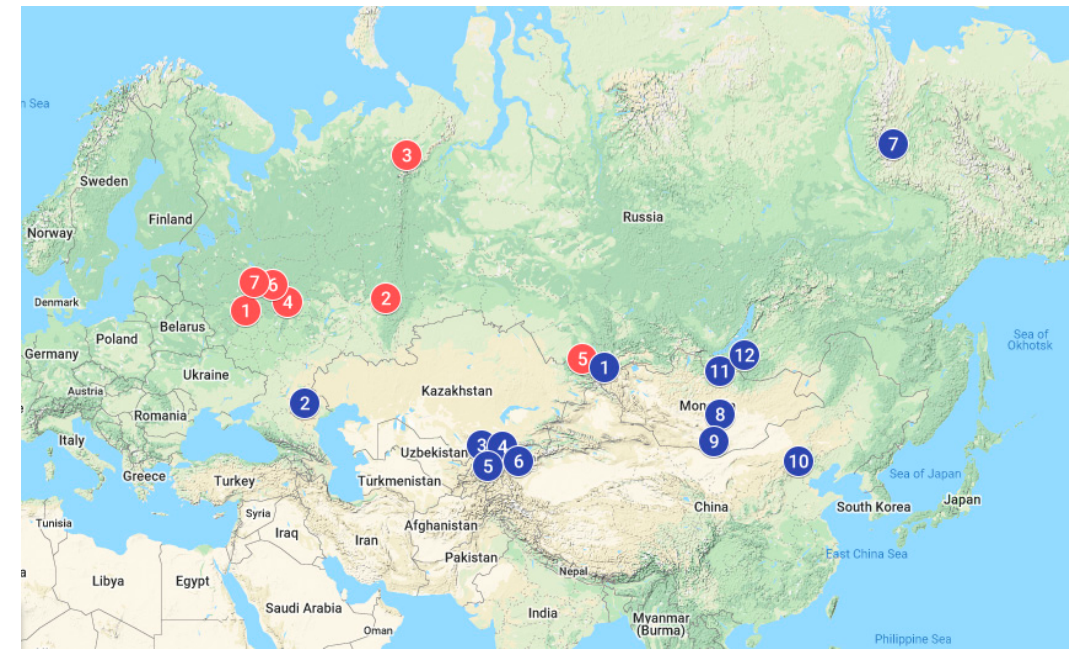
Figure 1. Geographic locations of cattle breeds. A total of 18 cattle breeds were sampled in this study, including eight European breeds indicated by red dots ((1). Holstein, (2). Tagil, (3). Kholmogory, (4). Red Gorbatov, (5). Ukrainian Grey, (6). Yaroslavl, (7). Brown Swiss and Kostroma) and ten Asian breeds indicated by blue dots ((1). Altai, (2). Kalmyk, (3). Aulie-Ata, (4). Kyrgyz Beef-type, (5). Alatau, (6). Kyrgyz native, (7). Yakut, (8). Khogorogo, (9). Gobi breeds, and (10–12) Buryat from China, Mongolia and Russia, respectively). (The map was downloaded from https://www.google.com/maps).